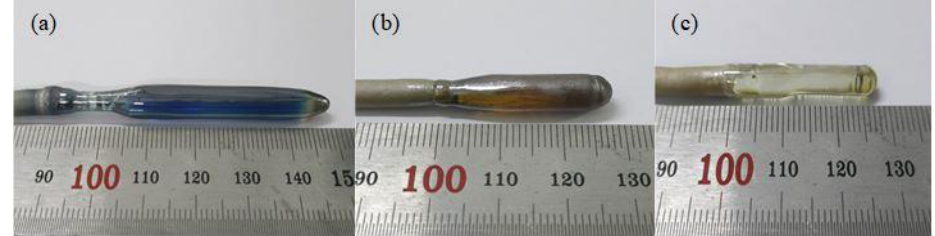
Figure 2. Crystals obtained under different oxygen content atmospheres: ( a ) high-purity Ar 2 , mixed gas ( b ) Ar 2 :O 2 = 1:1, and ( c ) Ar 2 :O 2 = 3:7.